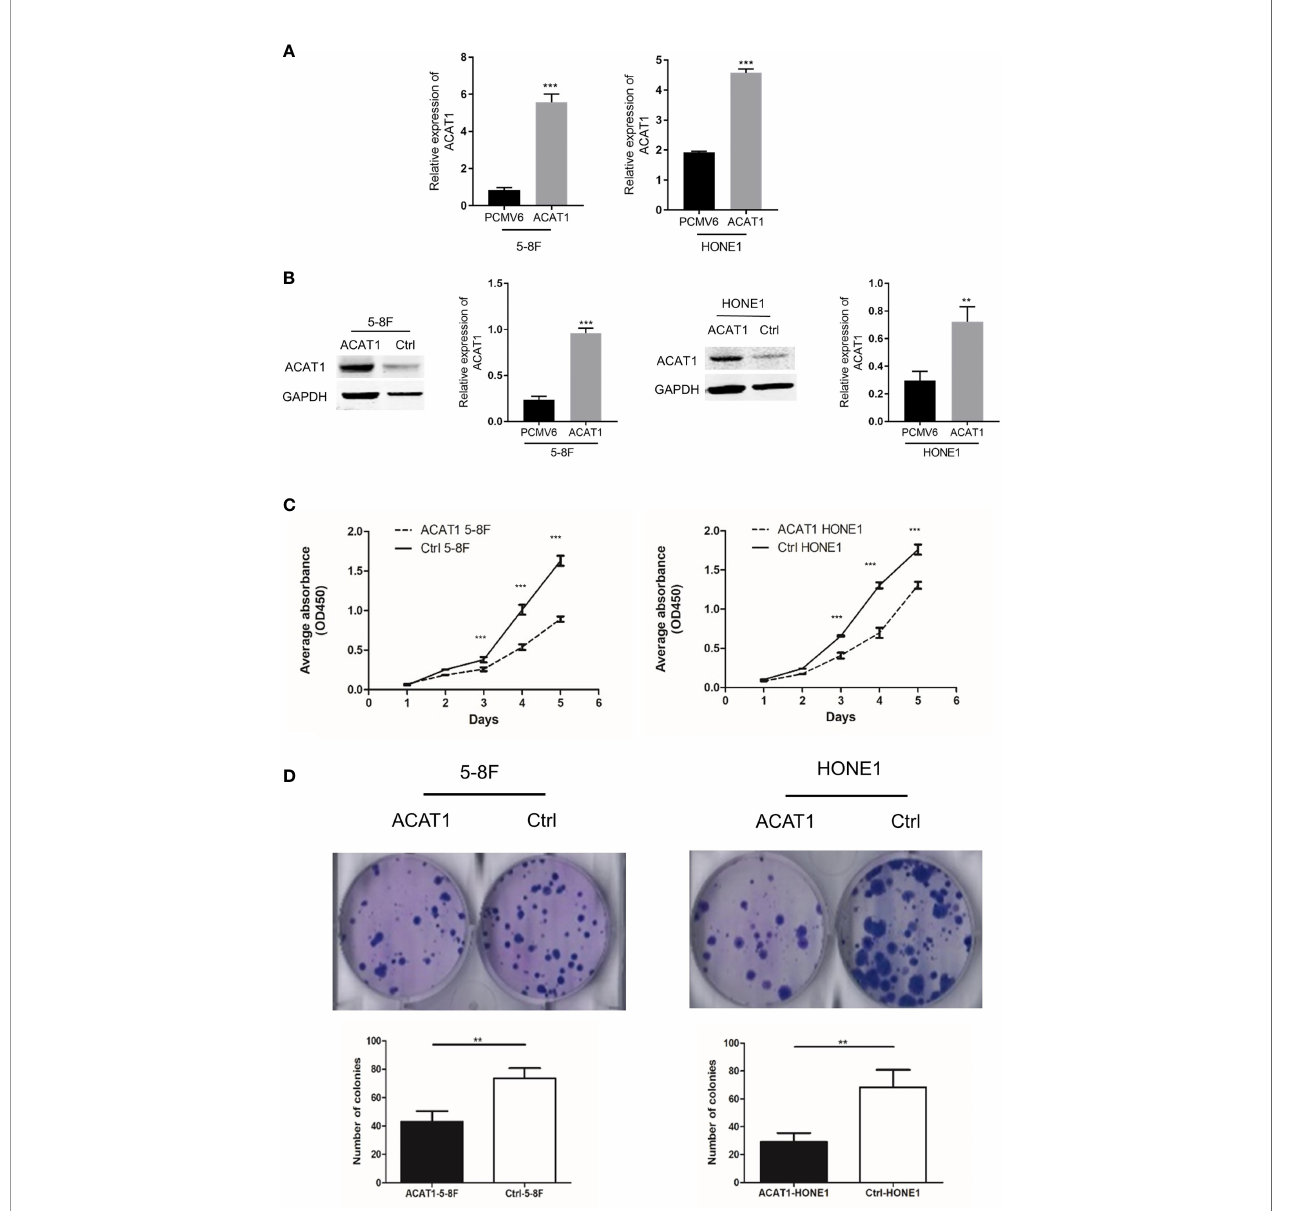
FIGURE 4 | Overexpression of ACAT1 inhibits proliferation. (A,B) ACAT1 expression in stably transfected 5-8Fand HONE1 celllines was con fi rmedby qPCR andwestern blotting, respectively. (C,D) Proliferation andcolony formation of ACAT1-5-8F and ACAT1-HONE1 cellsdetermined byCCK-8 assay (OD=450nm) and colonyformation assay,respectively. The independent Student ’ s t-test was used to analyze the results anddata are expressed as the means± SD.** p < 0.01; *** p <